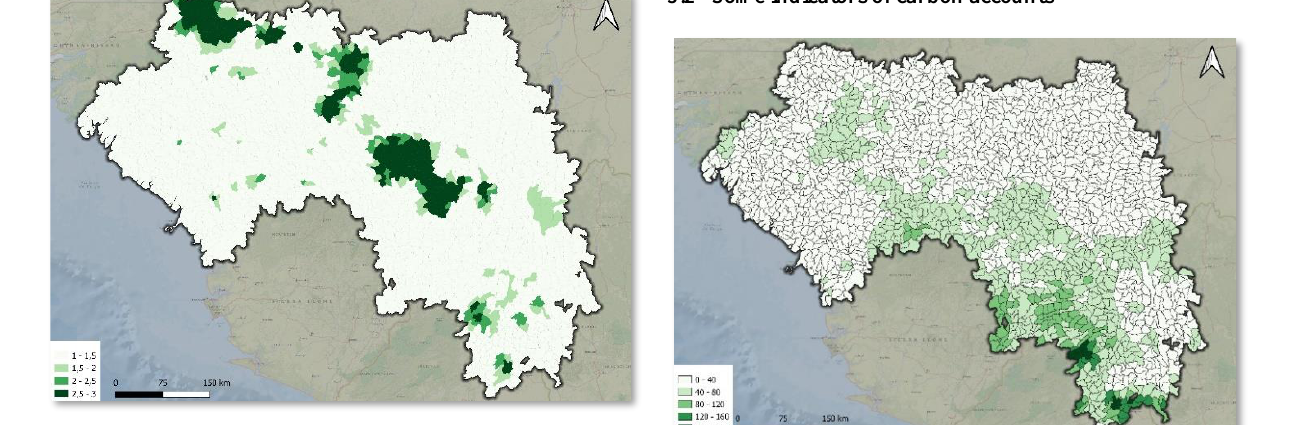
Figure 5. Map of the Landscape High Nature Value Index (LHNVI) by UPSE